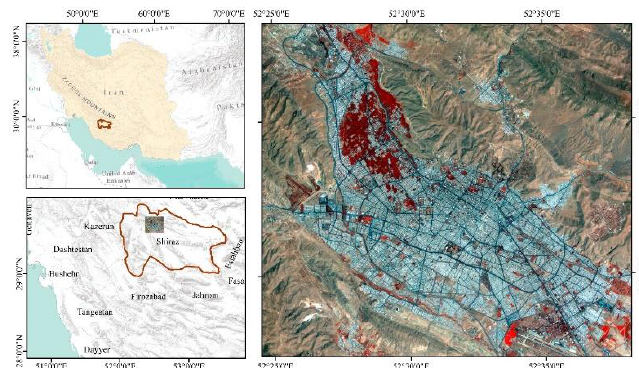
Figure 1. The study area: (a) location map; (b) Shiraz city; (c) Image of the study area in a false-color combination.